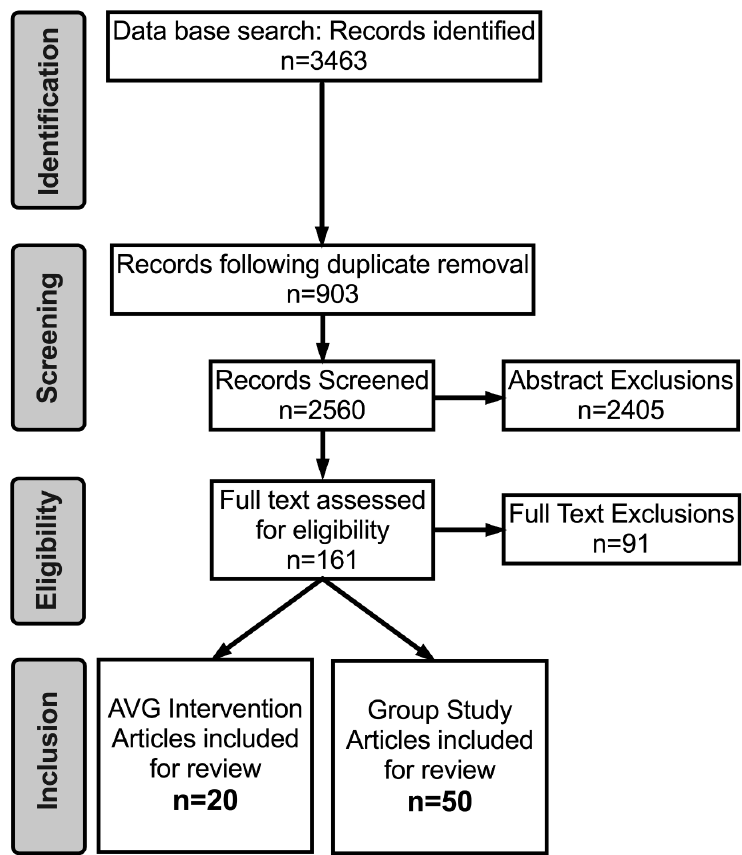
Figure 1. Flow chart demonstrating the identification, screening, eligibility and inclusion of articles identified for phase 1 (gaming and cognition) of the dual systematic review in accordance with PRISMA guidelines.